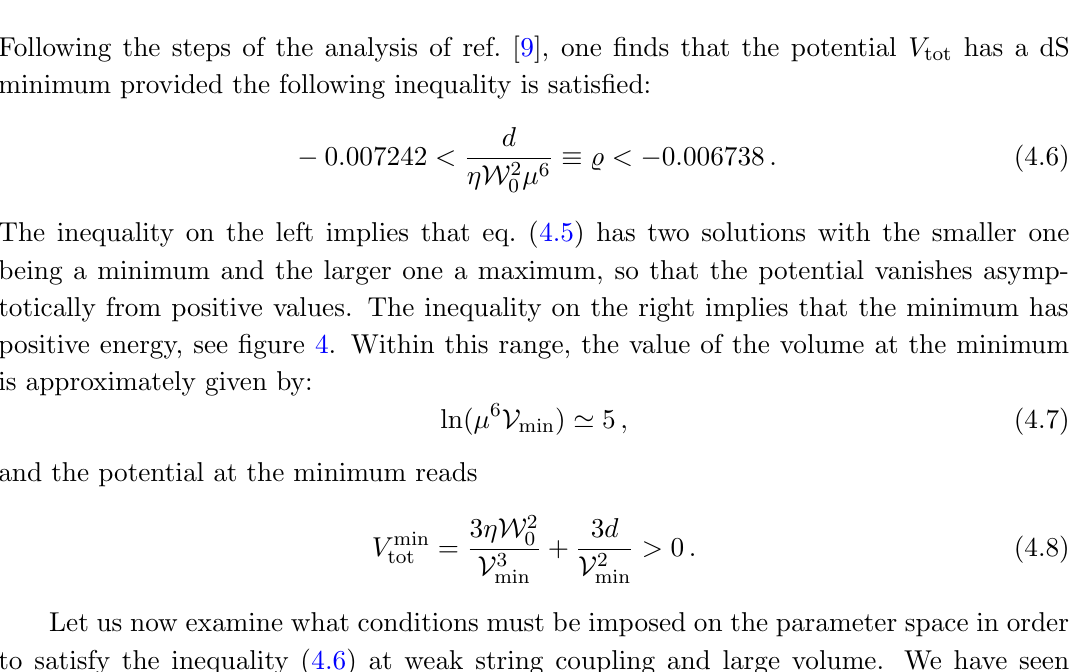
Figure 4 . Plot of V e(cid:11) vs V (in arbitrary units) for three values of the parameter % = d lower curve corresponds to AdS vacuum. At large V , V e(cid:11) vanishes asymptotically after passing from a